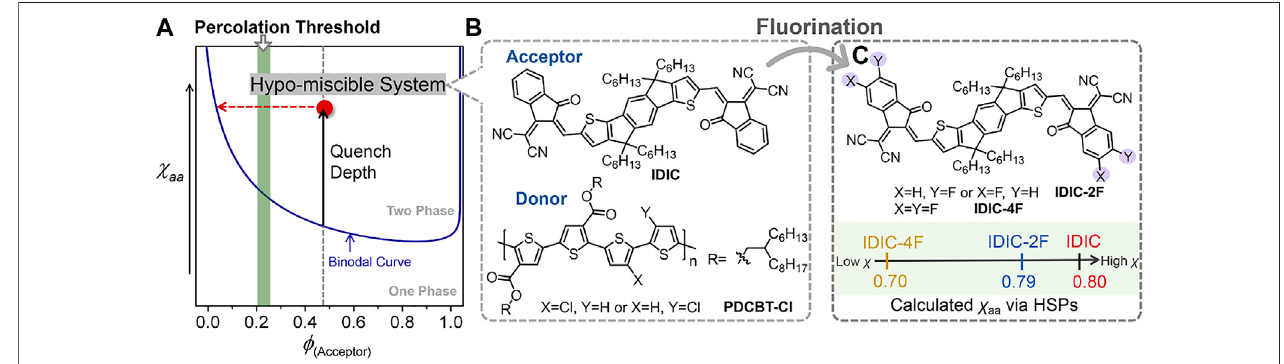
FIGURE 1 | (A) Illustration of the Flory – Huggins interaction parameter ( χ )-volume composition of acceptor ( ϕ ) phase diagram for the hypo-miscible system. (B) Chemical structures of IDIC and PDCBT-Cl. (C) Chemical structures of IDIC-2F and IDIC-4F, and the illustration of the calculated χ according to the Hansen Solubility